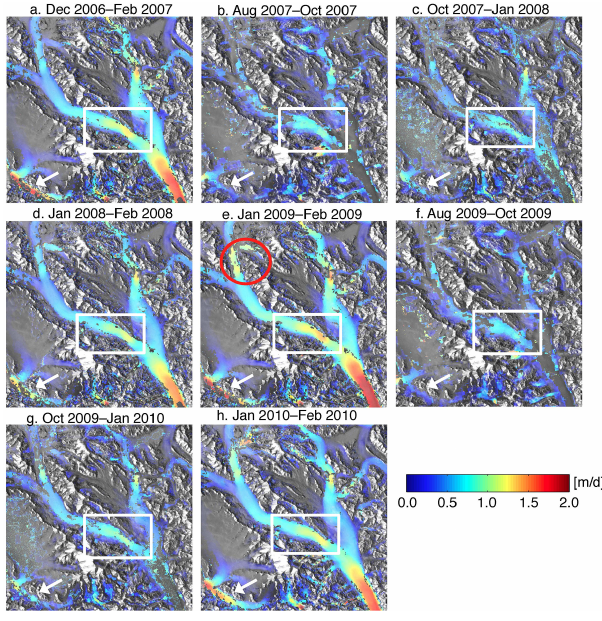
Figure 3. Spatial-temporal evolution of ice velocity at Hubbard Glacier and an upper tributary of Malaspina Glacier. The flow di- rection of Hubbard Glacier is from north to south. The white square marks a region in which the velocity in winter (a, d, e, h) ex- ceeds that of late summer and autumn (b, c, f, g) . The red circle in (e) marks a “mini-surge-like” signal in the upstream region dur- ing January–February 2009. The white arrow in this image shows a winter speed-up of an upper tributary of Malaspina